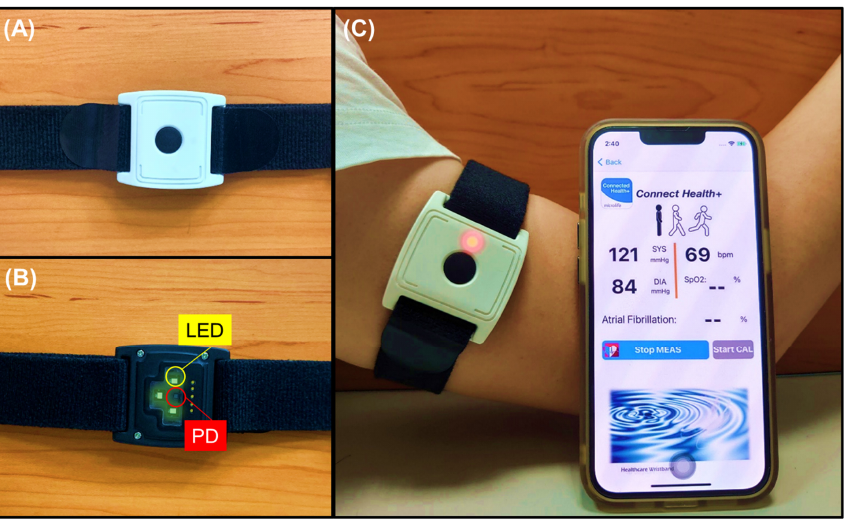
Figure 1. Our proposed cuffless BPM, based on the upper-arm reflective PPG detection. ( A ) The photography for the top view of the cuffless BPM, which presented a simple user interface with a power switch button and a LED-operated indicator. ( B ) The bottom view of the device showed the PPG hardware, consisting of three green LED elements and a PD arranged in a T-shape configuration, constructed with optical baffles to shade interferences from ambient light sources. ( C ) The BPM was worn on the upper arm, providing a cuffless BP measurement that was based on the reflective PPG signals. The measured data were wirelessly transmitted to a smartphone via the Bluetooth communication protocol and displayed the corresponding heart rate, SBP, DBP, and current posture on the